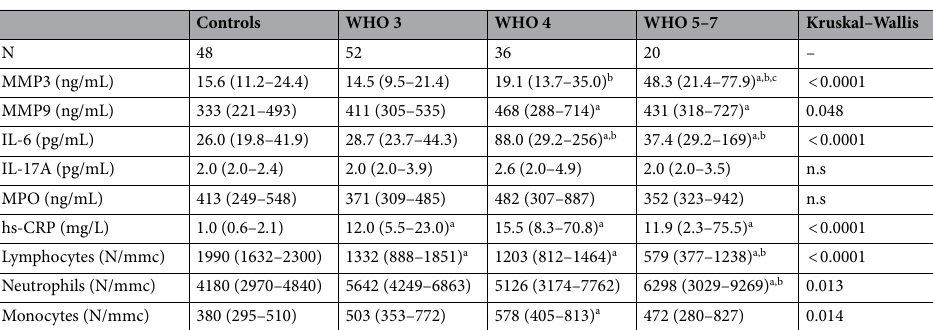
Table 2. Comparison of serum MMPs, inflammation markers and blood cells at admission in controls and COVID-19 patients with different severity according to worst WHO stage for each patient. Median and interquartile range. a p < 0.01, versus controls; b p < 0.01, versus WHO 3; c p < 0.01, versus WHO 4. hs-CRP high sensitivity C-reactive protein, IL interleukin, MMP matrix metalloproteinase, MPO myeloperoxidase, n.s . not significant.